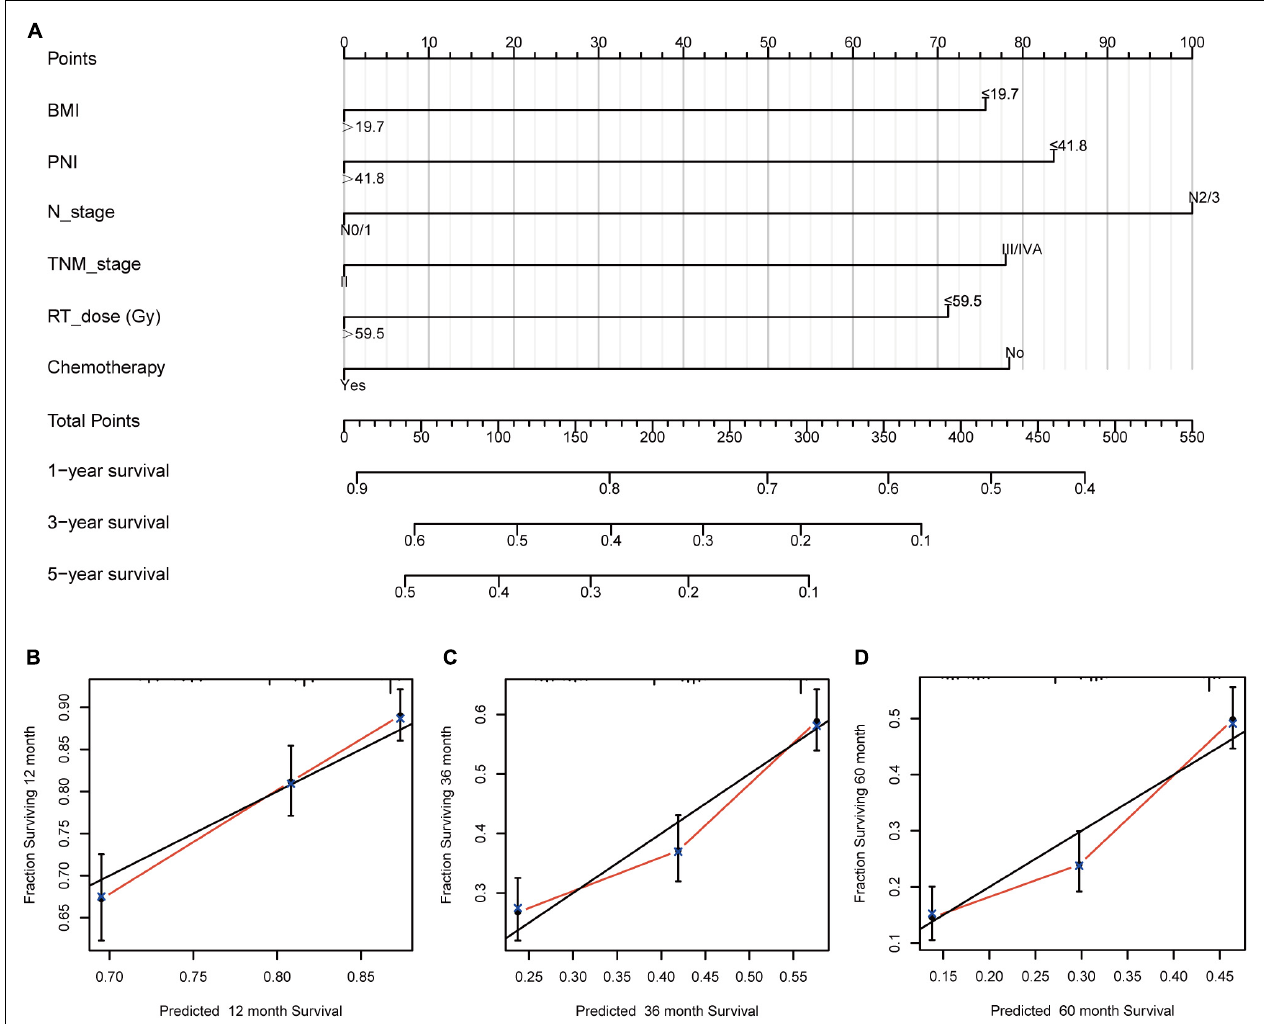
FIGURE 2 | Nomogram and calibration curve for predicting the probability of OS for the 1,068 patients showing (A) a nomogram that integrates BMI, PNI, N stage, TNM stage, RT dose, and chemotherapy in ESCC patients; (B–D) the calibration curve of the nomogram. OS, overall survival; BMI, body mass index; PNI, prognostic nutritional index; N, node; TNM, tumor-node-metastasis; RT, radiotherapy; ESCC, esophageal squamous cell